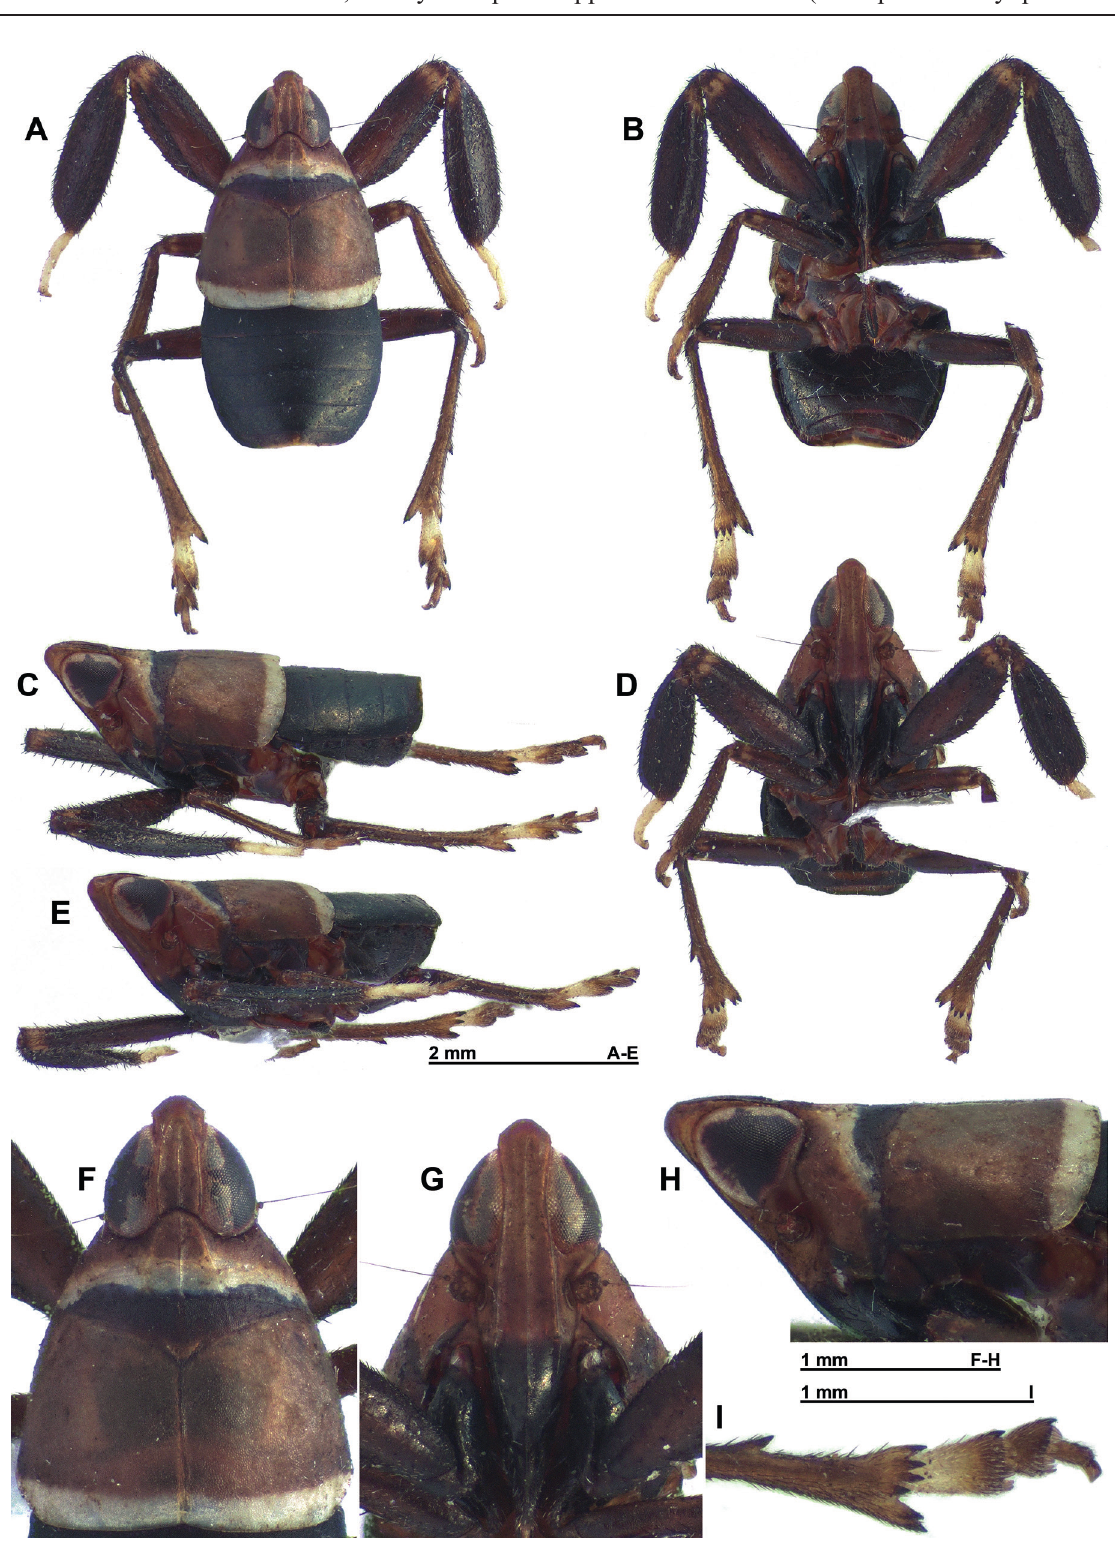
Fig. 13. Cleotyche ( Cleotyche ) montana sp. nov., ♂, holotype (QM). A . Habitus dorsal view. B . Habitus, ventral view. C . Habitus, lateral view. D . Habitus, perpendicular view of frons. E . Habitus, anterolateral view. F . Head and thorax, dorsal view. G . Frons, perpendicular view. H . Head and thorax, lateral view. I . Distal portion of posterior leg, ventral